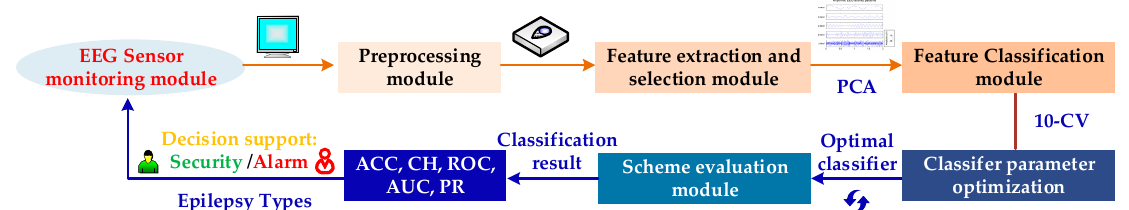
Figure 1. Auxiliary medical diagnostic system for epilepsy electroencephalogram.